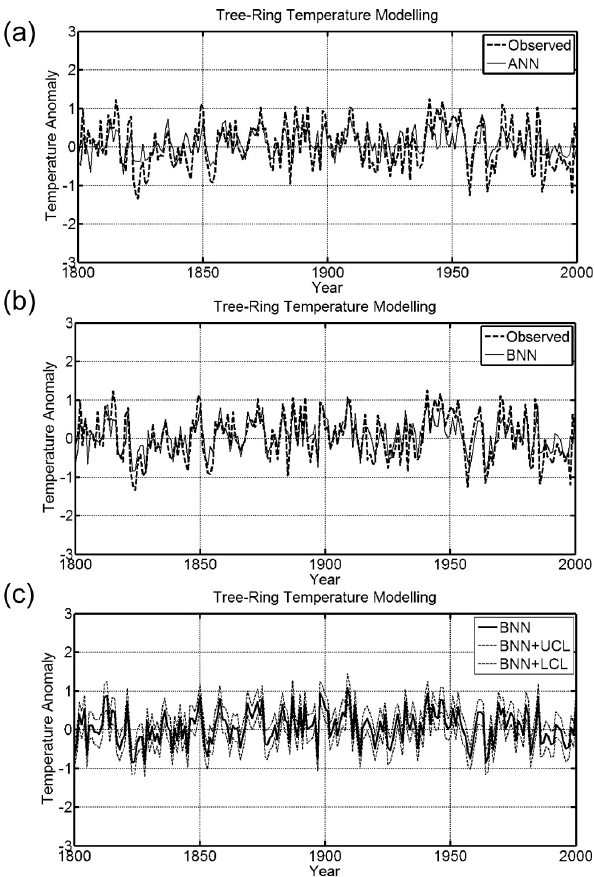
Fig. 8. One lag temperature anomaly reconstruction in the period (AD1800–2000) using (a) artificial neural network (b) Bayesian neural network(BNN) (c) BNN with confidence level (CL) of 95%.